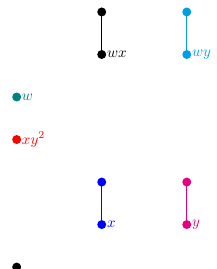
Figure 10. The A (1) -module structure of H • ( BQ 8 ; Z / 2) up to degree 5 .